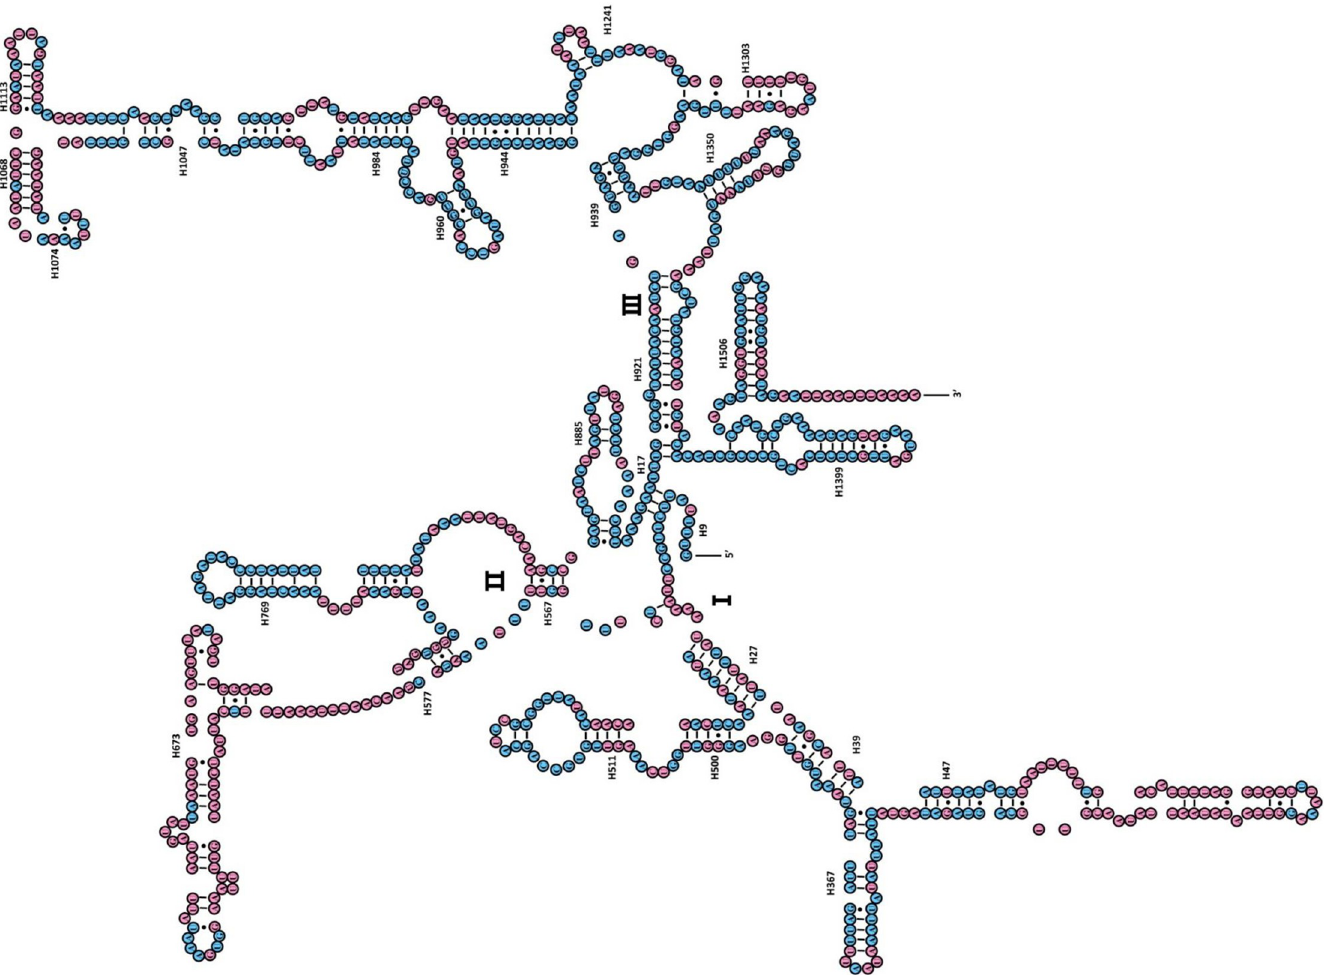
Fig 4. Inferred secondary structure of rrnS of Amorphoscelis chinensis . Inferred Watson-Crick bonds are illustrated by lines, whereas the noncanonical interactions are illustrated by dots.